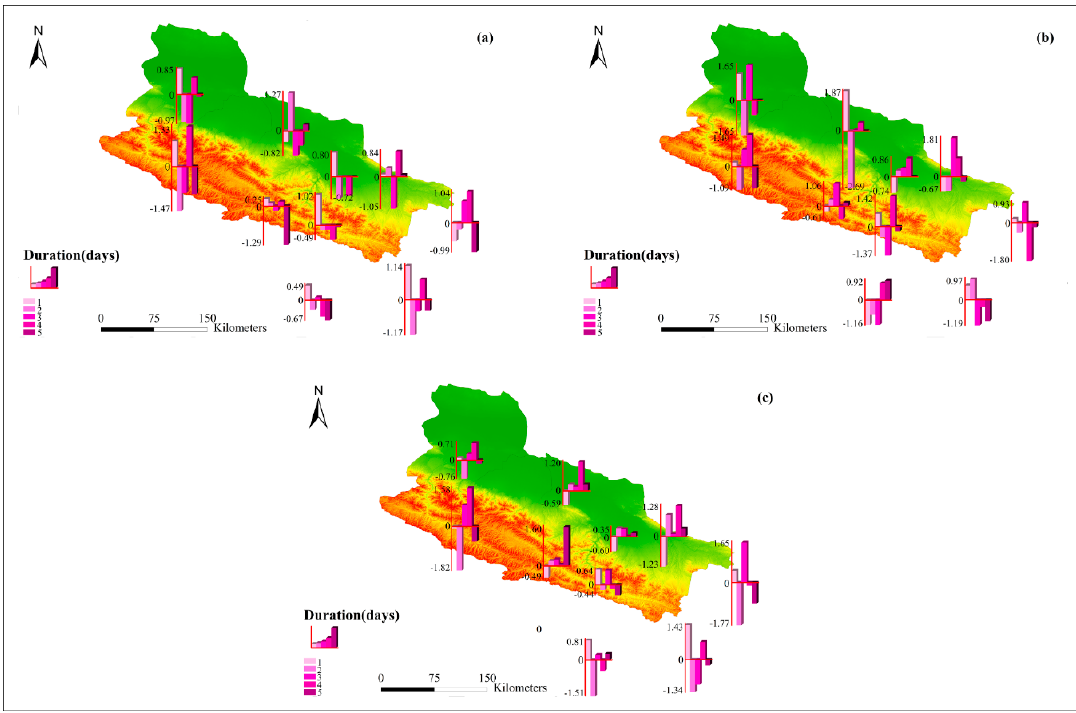
Figure 4. Spatial distribution of normalized occurrences of Mann–Kendall Z values for different wet periods (WPs) before ( a ) and after ( b ) abrupt changes and over the total period ( c ) over the upper (UHRB) and the middle (MHRB) reaches of the Heihe River Basin.